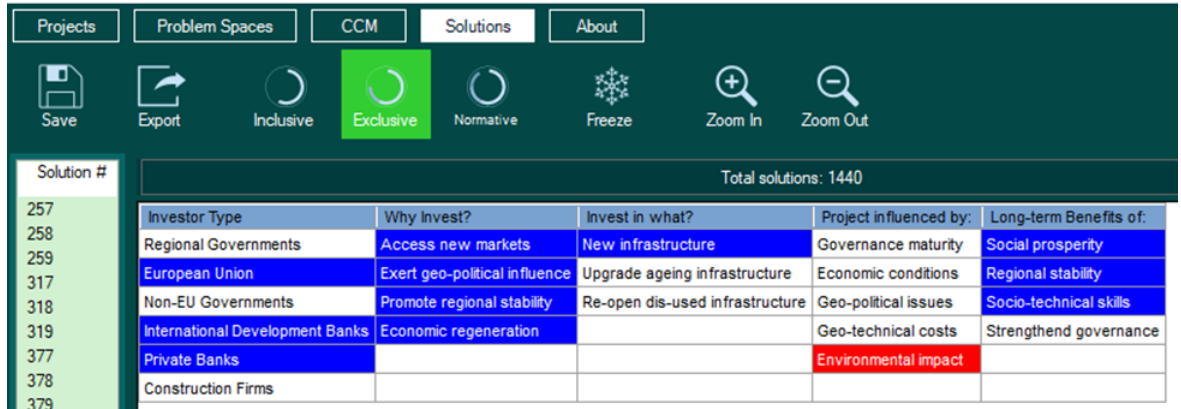
Figure 7. An example of the resulting ‘solution space’ following the CCA. By selecting ‘Environmental impact’ as a driver, 23 solutions are obtained listed on the right-hand side that can be drilled down further by selecting another parametric